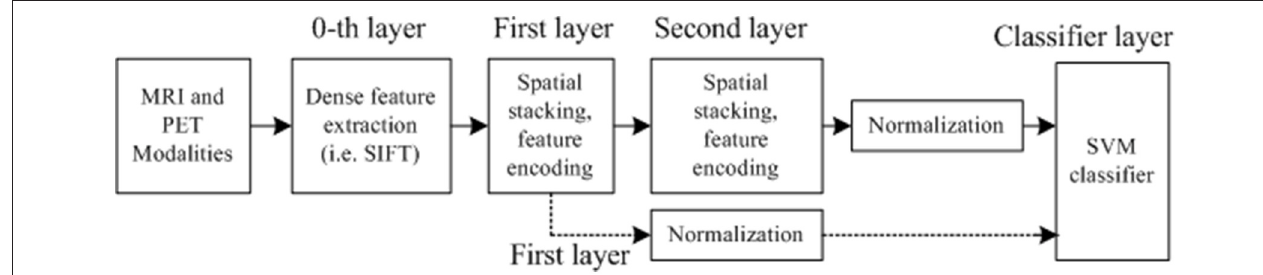
FIGURE 3 | The deep feature architecture for the AD